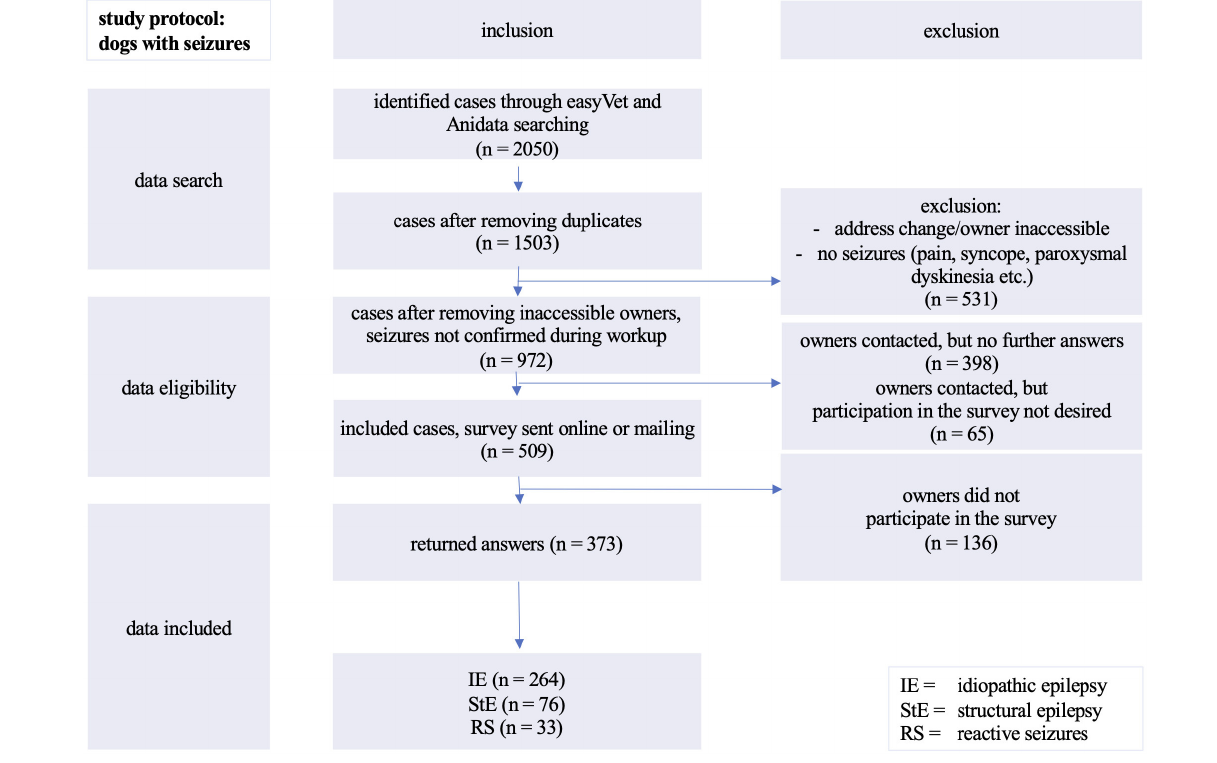
FIGURE 1 | Inclusion of evaluated cases: analyzed cases of dogs with seizures presented between 01/1998 and 05/2018 at the Department of Small Animal Medicine and Surgery, University of Veterinary Medicine in Hannover,